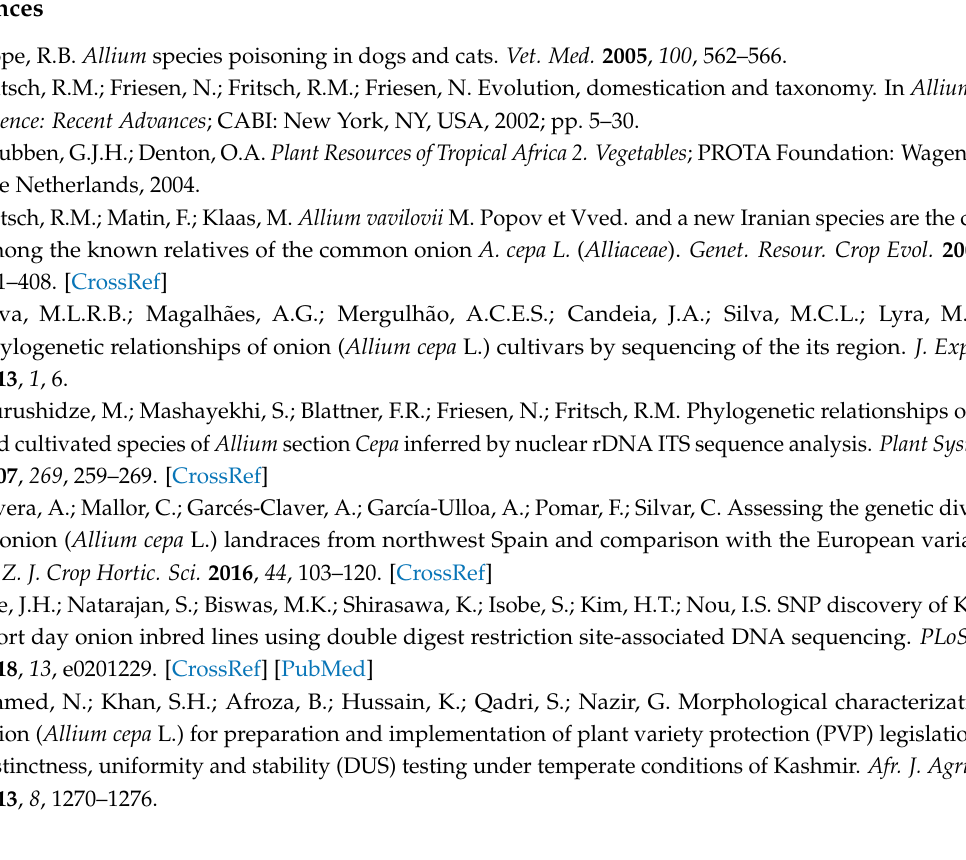
Figure S1: Call map view from the dynamic array of single nucleotide polymorphism (SNP) fingerprints of genotyped onion varieties from the Fluidigm Genotyping Analysis Software. Table S1: Allele frequencies in 16 samples ( N = 16) from each of the seven open-pollinated onion cultivars at the 43 different SNP markers. Allele/n designates the positions of the SNP under each marker, which are variable across the seven